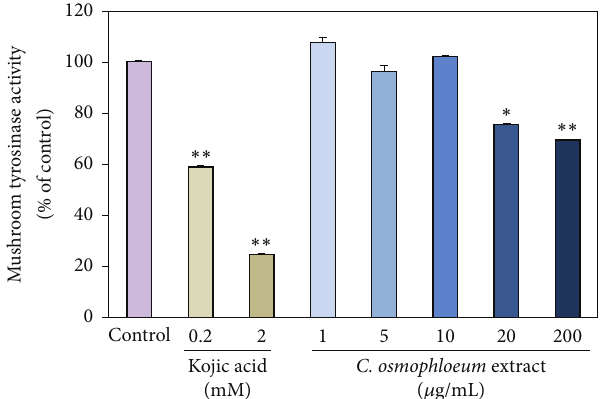
Figure 4: The inhibitory effects of various concentrations of C. osmophloeum extracts and kojic acid on mushroom tyrosinase for 5 minutes. Data: the mean value ± SD (triplicate values in three independent experiments); ∗ < 0.01 , ∗∗ < 0.001 .